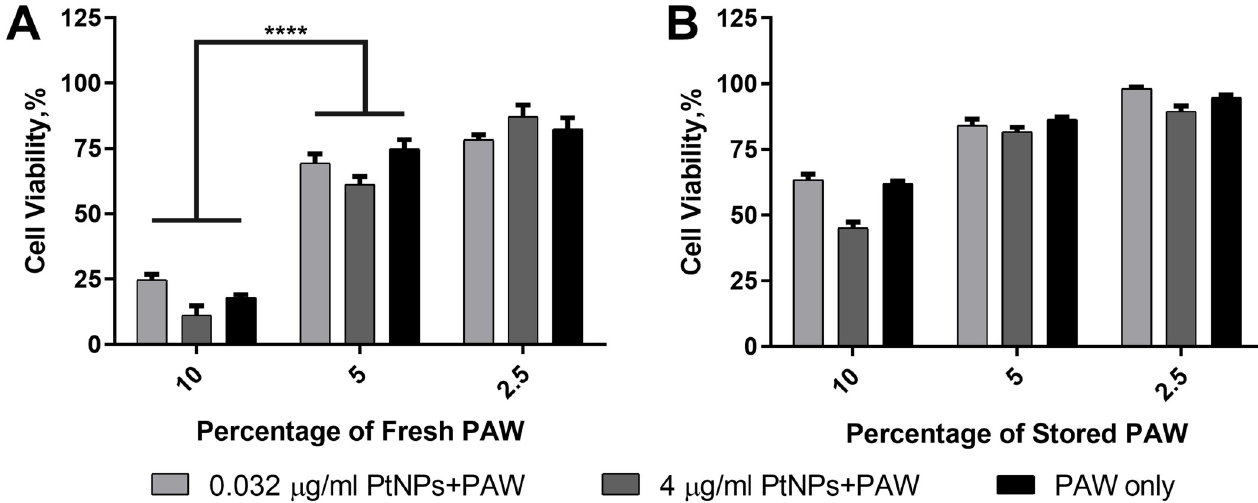
Fig 5. Difference between freshly prepared or stored PAW treatment on cells. U-251 MG cells were incubated with 0.032 and 4 μ g/ml PtNPs for 24 h and then treated with 2.5, 5 and 10% freshly prepared PAW (A) or 24 h stored PAW (B) . Alamar blue cell viability assay was carried out 48 h after PAW treatment.